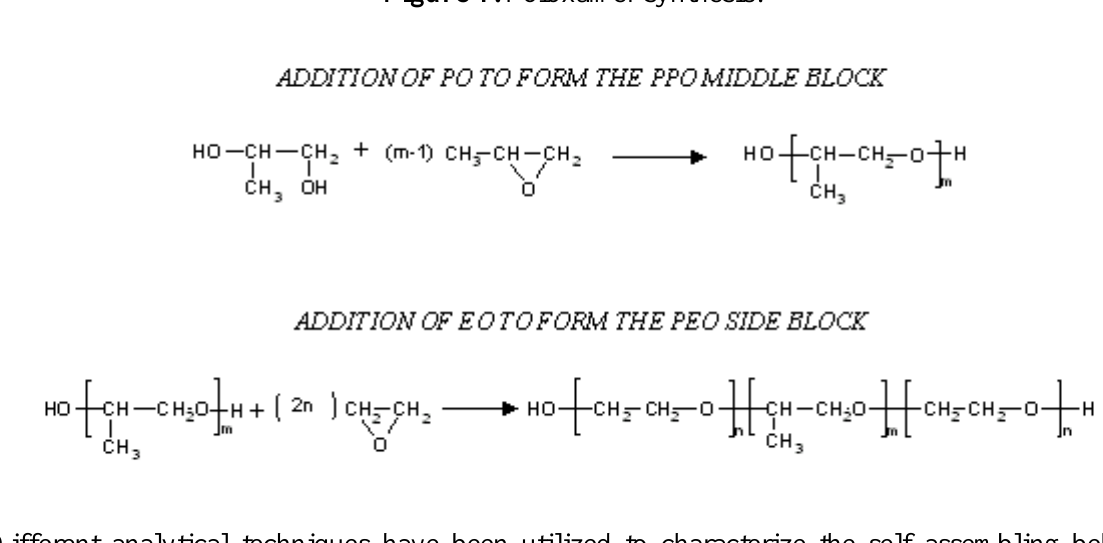
Figure 1. Poloxamer